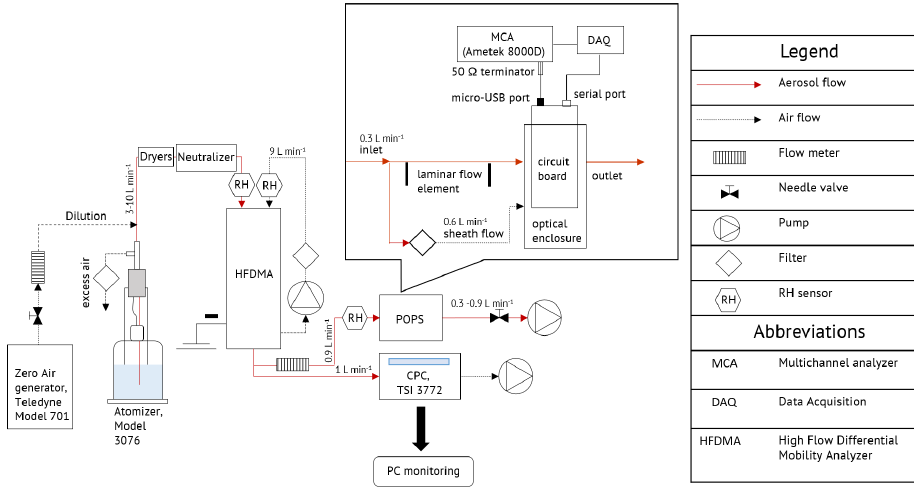
Figure 1. Schematic of the modified POPS instrument and size-resolved characterization experiments.